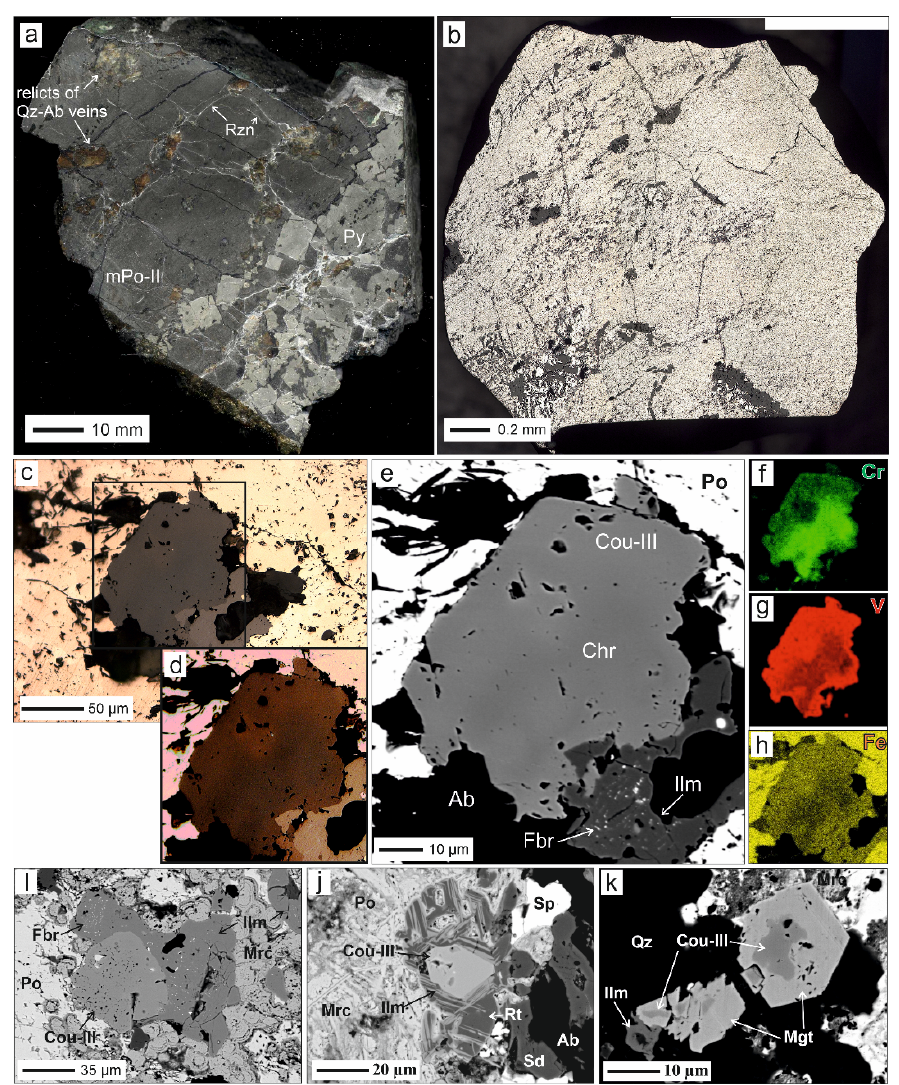
Figure 6. Coulsonite-III (Cou-III) in the massive pyrrhotite ore of type II (mPo-II): ( a )—polished sample of mPo-II (Py—pyrite; Rzn—rozenite); ( b )—mPo-II in a polished section (reflected light images), ( c , d )—coulsonite (brown) with a relic of chromite (Chr, dark grey) in mPo-II; (reflected light images); ( e )—BSE image of coulsonite from ( c , d ); ( f – h )—element mapping of coulsonite from ( c , d ); ( i , j )—coulsonite-III intergrowth with V-bearing ilmenite (Ilm) ( i ) and rutile(Rt)-ilmenite aggregate ( j ); ( k )—rim of magnetite around coulsonite-III. Ab—albite, Qz—quartz, Mrc—marcasite, Sd—siderite, Sp—sphalerite.